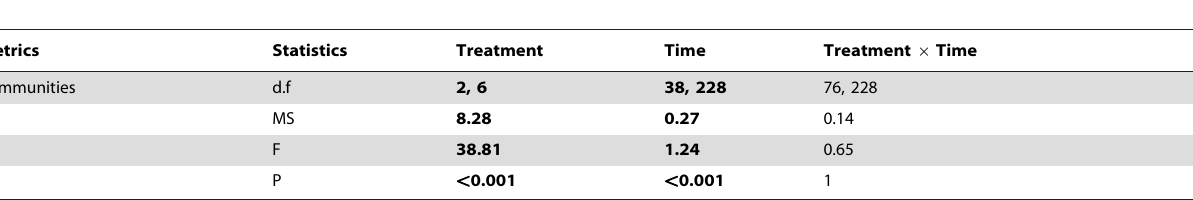
Table 2. Results of PERMANOVA contrasting phytoplankton communities between lakes (circum-neutral, acidified and limed), time (year) and their interactions.